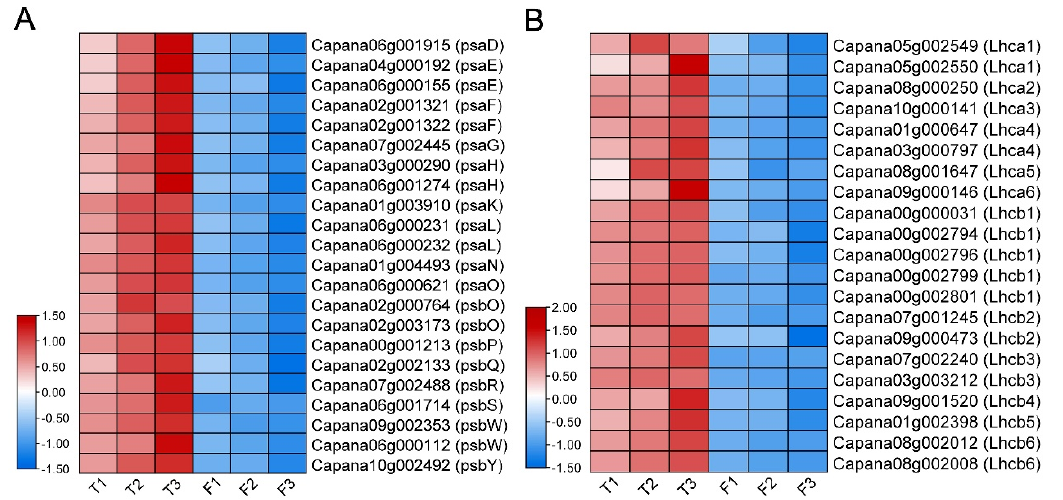
Figure 7. Heat maps of photosynthesis-related genes in PS I and PS II. ( A ) Heat map of 22 structural protein genes (13 Psa subunit genes and 9 Psb subunit genes). ( B ) Heat map of 21 antenna protein genes (8 Lhca genes and 13 Lhcb genes). T1 − T3 and F1 − F3 represent three biological replicates of negative controls (pTRV2-C2b) and CaFtsH1 -silenced plants (pTRV2-C2b-CaFtsH1), respectively.